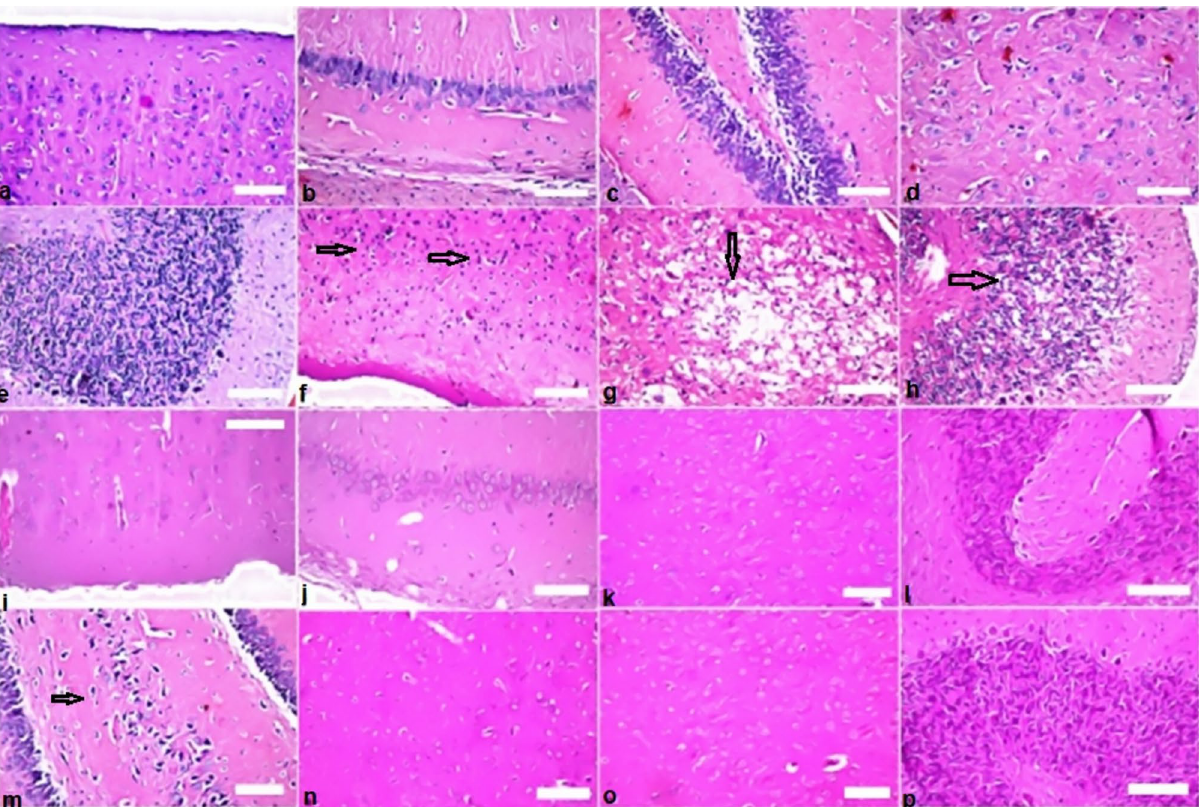
Figure 9. Histopathological findings in brain (a–e) showing normal histopathological of the cerebral cortex of rat. (a) The control group showing normal appearance of the nerve cells. (f–h) Rats which exposed to gamma rays at dose 6 Gy revealed nuclear pyknosis (arrows) (score 3), degeneration (score 2), and cellular vacuolization (score 2) were detected in the neurons of central cortex, striatum and cerebellum respectively. (i,j) Rats were administered BV 0.05 mg/kg showed no alteration (score 0) of the brain. (k,l) The group of animals were administered propolis (300 mg/kg): there was no histopathological alteration as recorded in brain. (m) Nuclear pyknosis and degeneration (arrow) (score 1) were in some neurons of fascia dentata in the group of rats administered propolis 300 + BV 0.05 mg/kg. (n–p) Normal histological structures (score 0) of brain occurred in the normal rats administered propolis, BV, and combined treatment (Pr + BV)